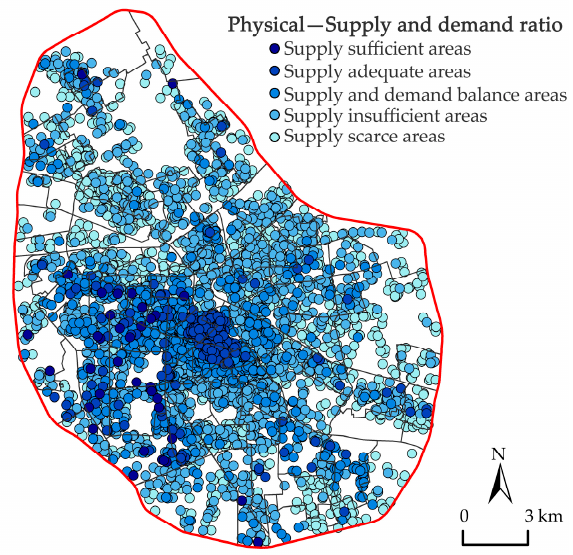
Figure 9. Schematic diagram of SDM assessment of public physical health resources in the research area. Table 6. Hierarchical statistics of SDM of public physical health resources in central Tianjin.